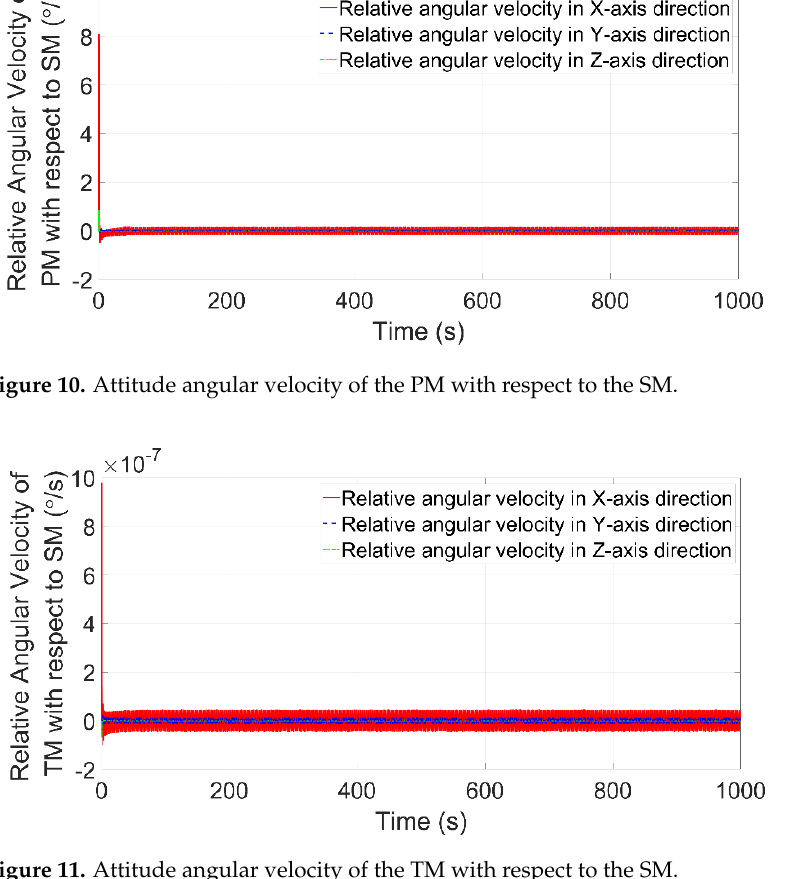
Figure 11. Attitude angular velocity of the TM with respect to the SM.